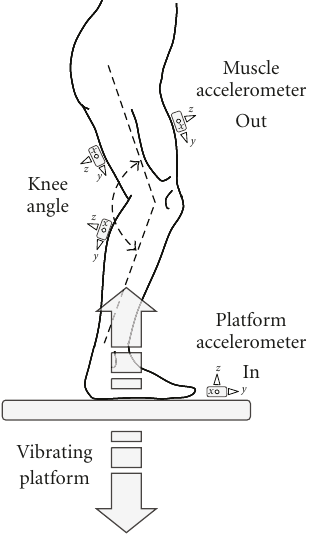
Figure 3: Scheme of measurement